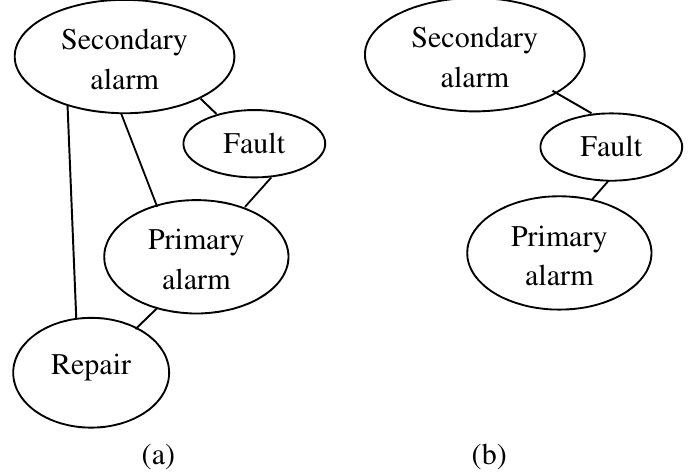
Figure 4. Moral graphs for finding conditional independence